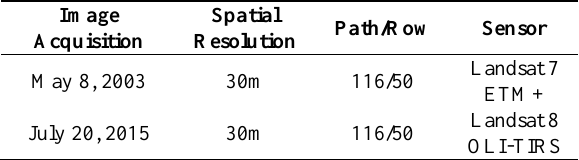
Table 1. Detailed information of the Landsat satellite images acquired for analysis